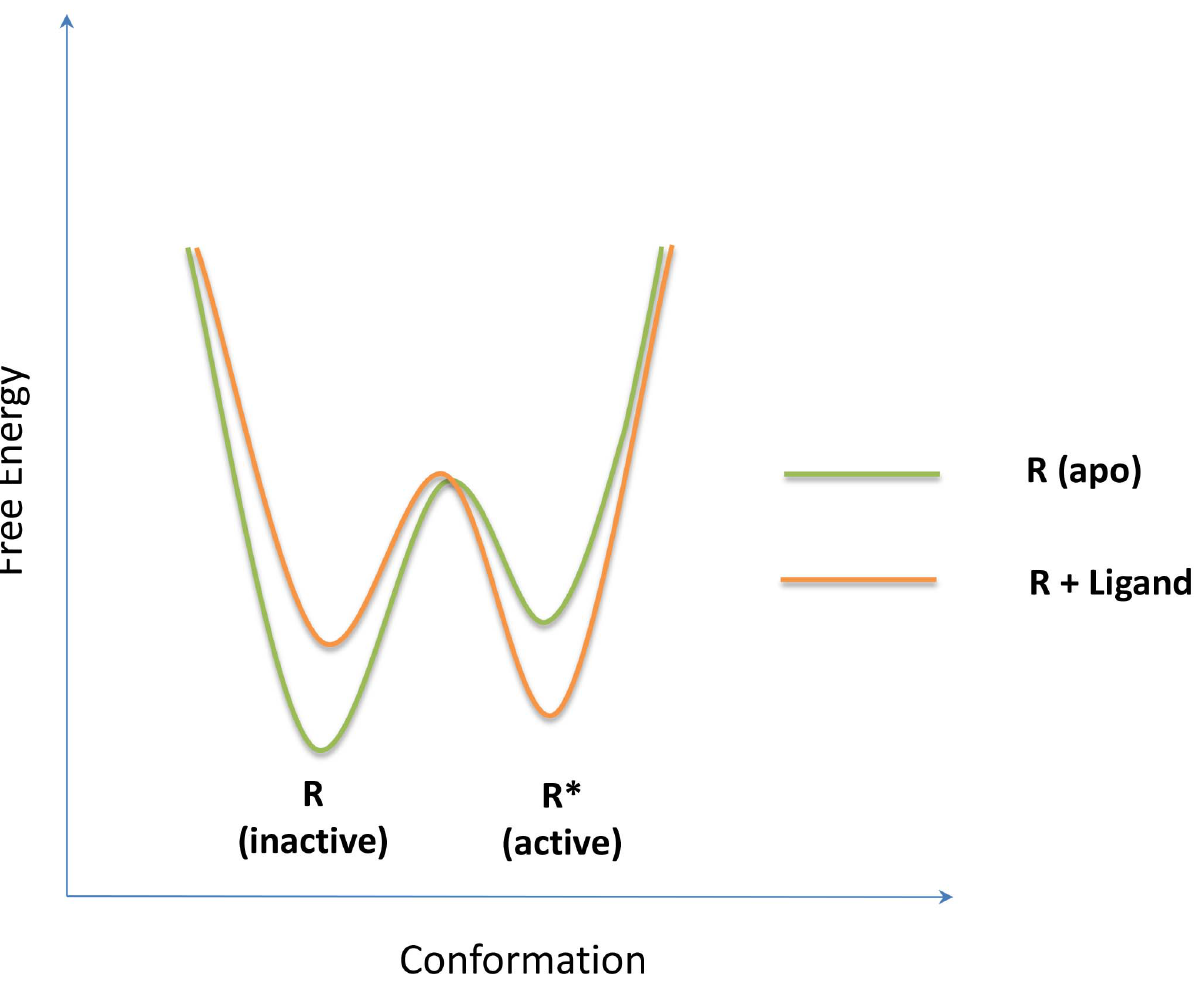
Figure 3. The simplest free energy landscape presentation of the thermodynamic view of allostery. At the bottom of the folding funnel, an apo protein is optimized to populate two states, R (inactive) and R (cid:2) (active), with each basin representing an ensemble of conformations and their relative populations as determined by the relative depth of the local basins. Allostery is clearly seen by a population shift from the inactive state dominated by apo (light green) to the active state prevailing in the complex (pale orange) through allosteric ligand